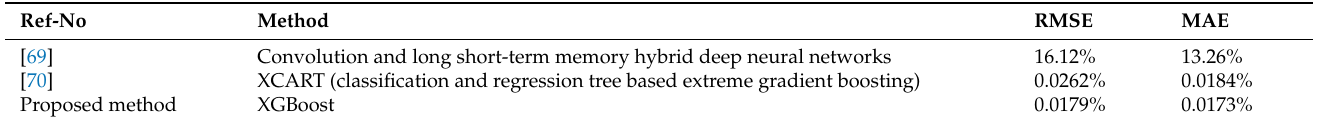
Table 4. Comparison of error rates between previous approaches and the proposed method.